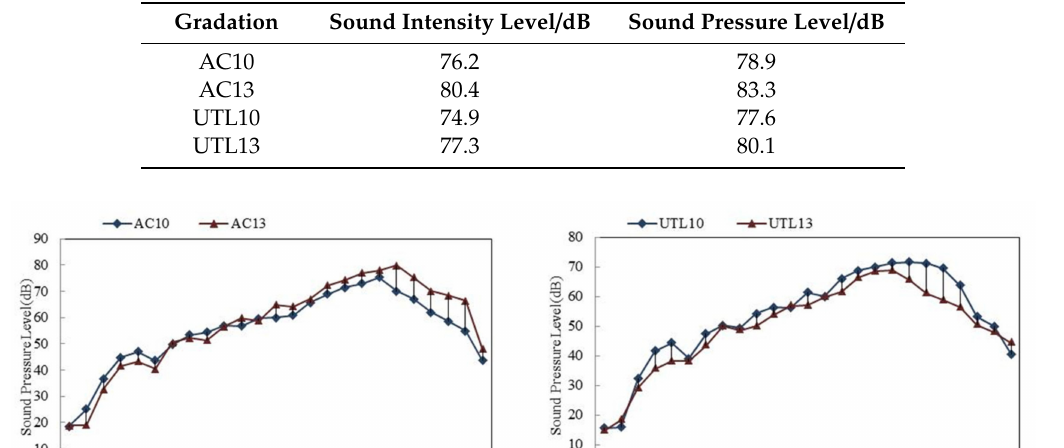
Table 4. Noise test results of asphalt mixture with di ff erent gradations.